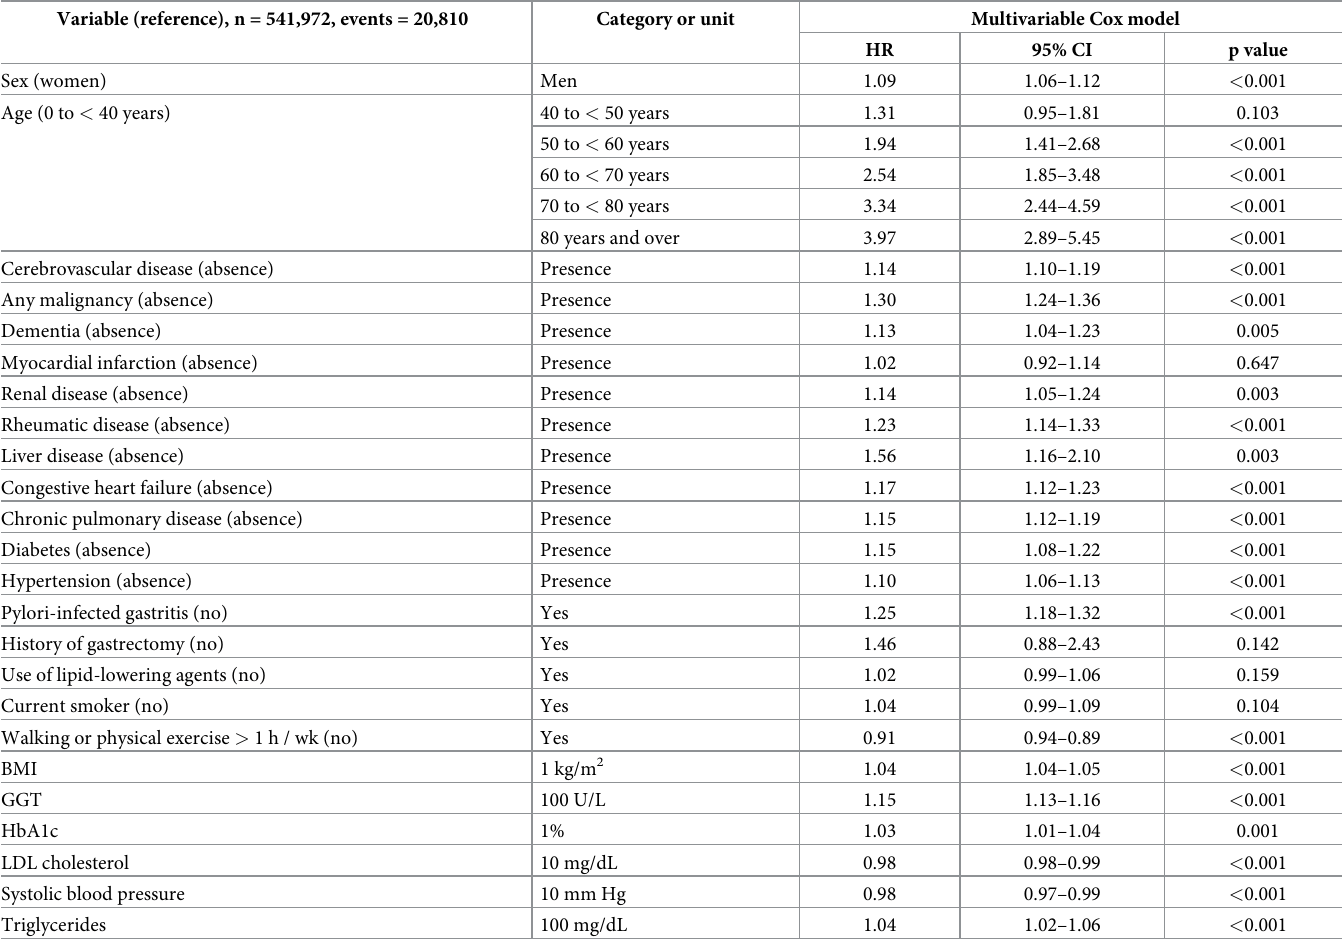
Table 3. Results of multivariable Cox model